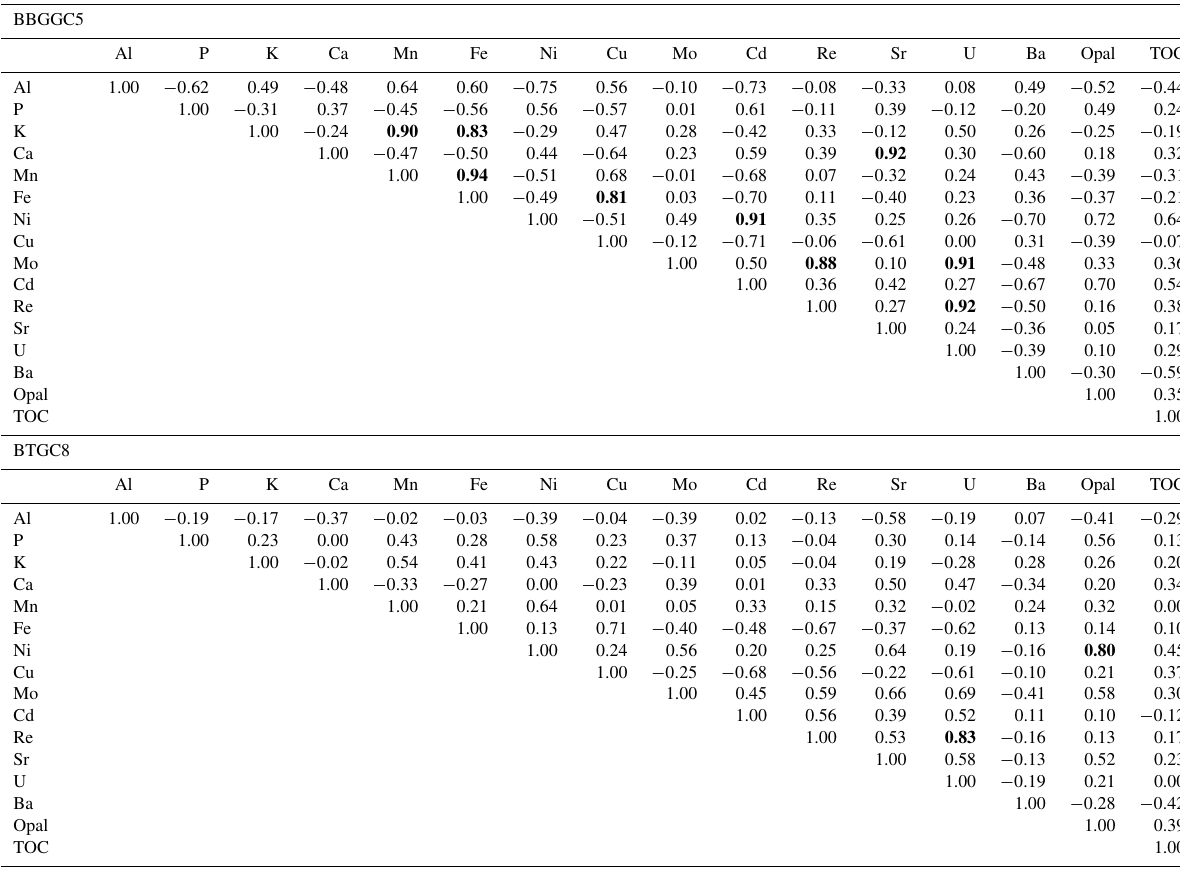
Table 4. Spearman rank order correlations for geochemical data. Significant values > 0 . 8 are indicated in bold.